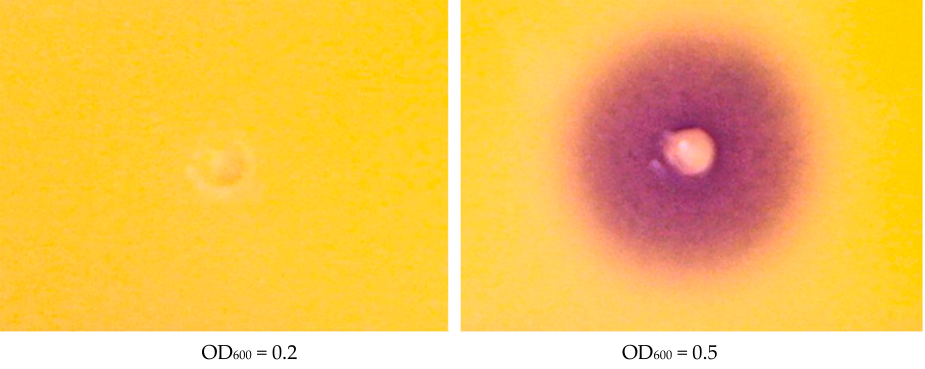
Figure 1. CV026 bioassay results from samples of the wild-type collected at OD 600 = 0.2 and OD 600 = 0.5. The purple halo indicates presence of acyl homoserine lactones (AHLs) in culture supernatant at OD 600 = 0.5. The purple colour is a result of violacein pigment production by the CV026 bio reporter strain. The absence of purple colour at OD 600 = 0.2 shows absence of AHLs and absence of quorum sensing.